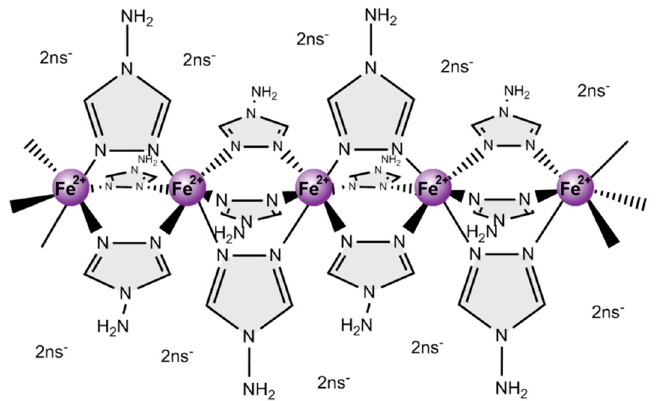
Figure 1. Schematic representation of the structure of the coordination polymer with the generic formula [Fe(NH 2 trz) 3 ](2ns) 2 .